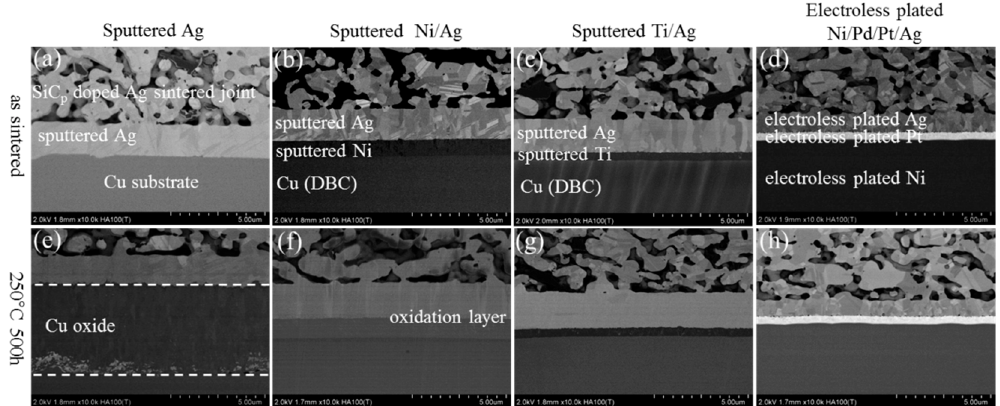
Figure 6. Evolution of SiC p doped Ag sintered joint with various substrates in as-sintered state and after HTS for 500 h: ( a – d ) as sintered state, ( e – h ) after HST for 500 h.